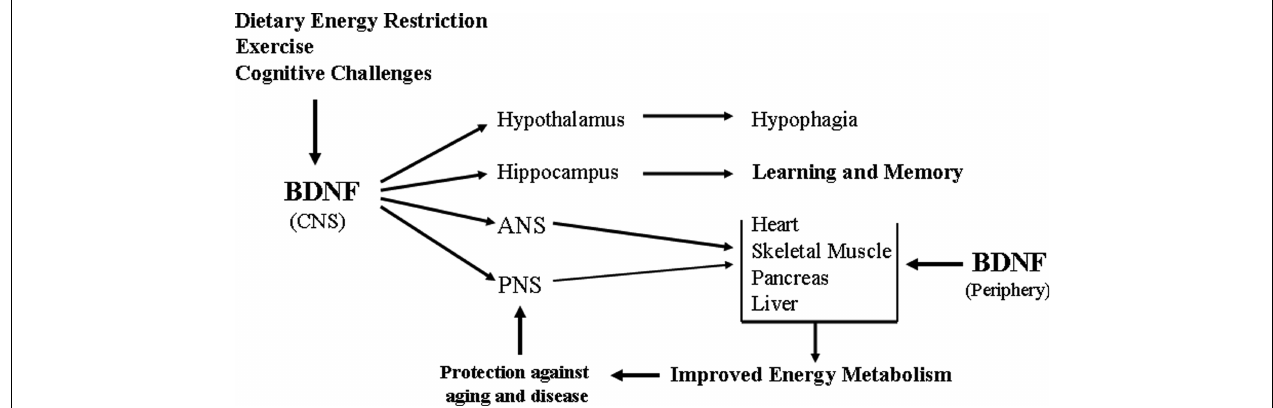
FIGURE 3 | Pivotal roles for brain-derived neurotrophic factor in the integration of CNS neuroplasticity and peripheral energy metabolism. The production of BDNF by neurons in the central nervous system (CNS) is increased in response to the metabolic and electrochemical challenged imposed upon the neurons by dietary energy restriction, exercise and cognitive stimulation. BDNF acts a multiple levels of the nervous system to engage adaptive responses to the environmental demands. BDNF acts on: neurons in the hypothalamus to reduce appetite; cells in the hippocampus to enhance synaptic plasticity, neurogenesis and learning and memory